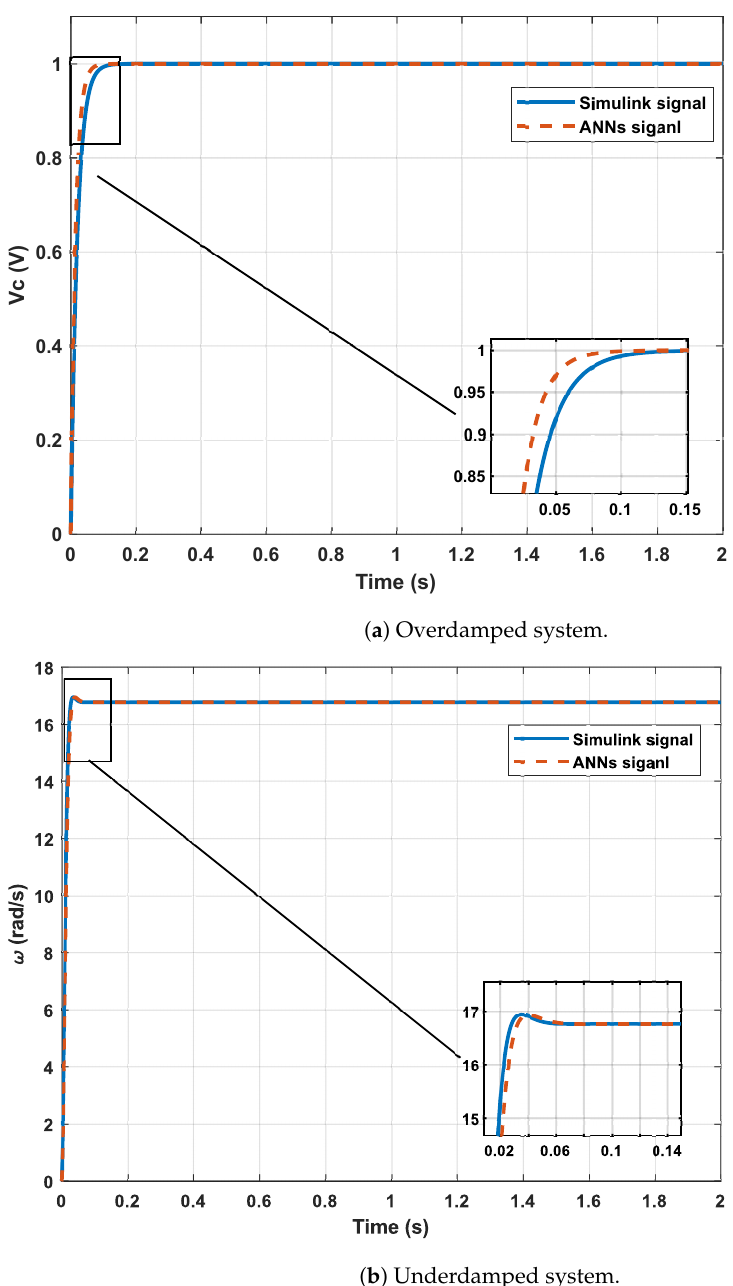
Figure 5. Systems used for testing the ANN with real